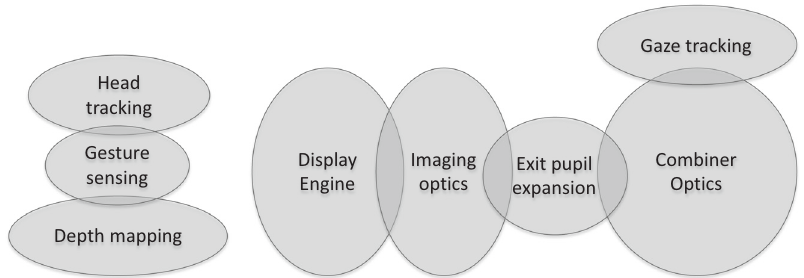
Figure 3: Functional optical building blocks of an MR system.